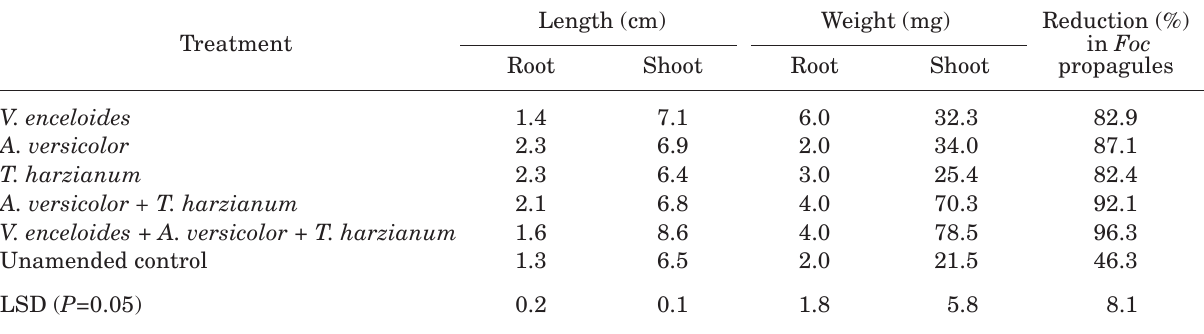
Table 4. Effect of Aspergillus versicolor, Trichoderma harzianum and V. enceloides residues on growth of cumin and survival of Fusarium oxysporum f. sp. cumini ( Foc ) propagules.